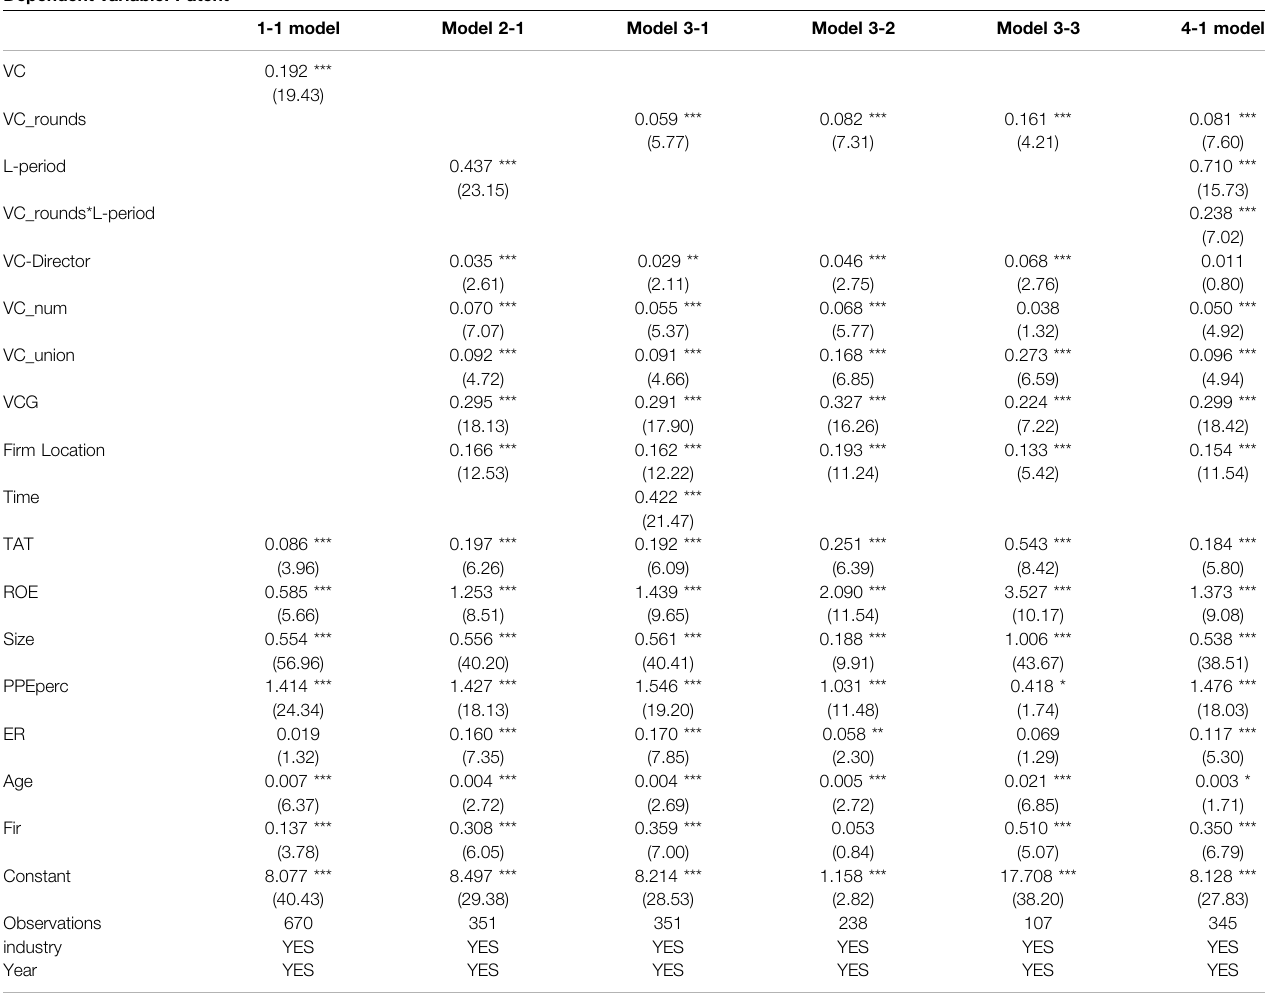
TABLE 4 | Regression